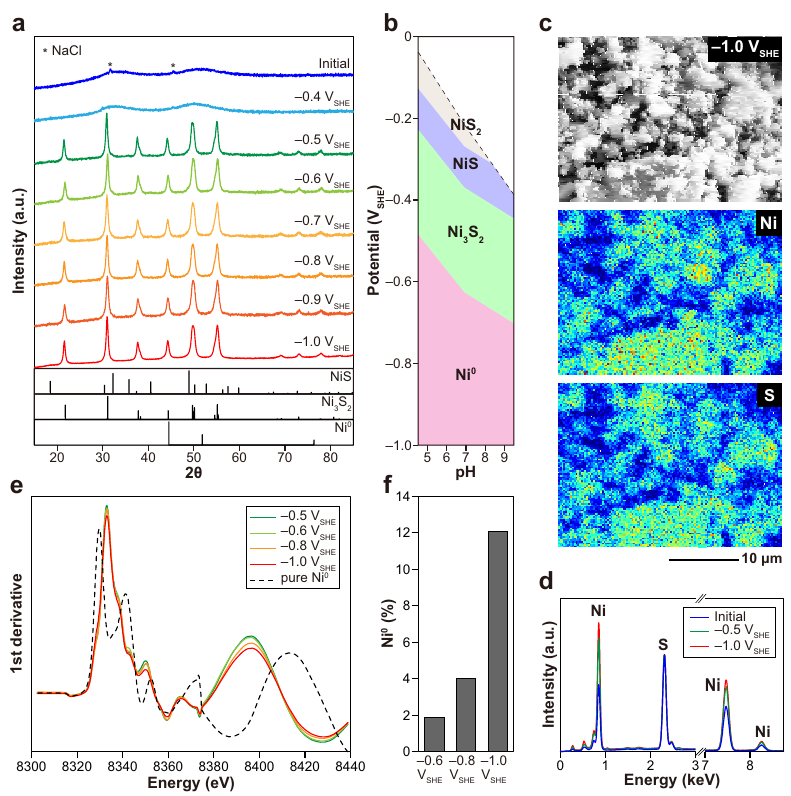
Fig. 1 Characteristics of the electrolyzed NiS. a XRD patterns showing NiS electroreduction to Ni 3 S 2 at – 0.5 V SHE or below. b E H -pH diagram for the sul fi de/metal system of Ni. c EDX mapping results of the NiS electrolyzed at – 1.0 V SHE . d Normalized EDX spectra of NiS before (blue) and after the electrolysis at – 0.5 V SHE (green) or – 1.0 V SHE (red). e First derivative nickel K-edge XANES spectra. f The percentages of Ni 0 in the electrolyzed NiS quanti fi ed by the XANES analysis (see “ Methods ”